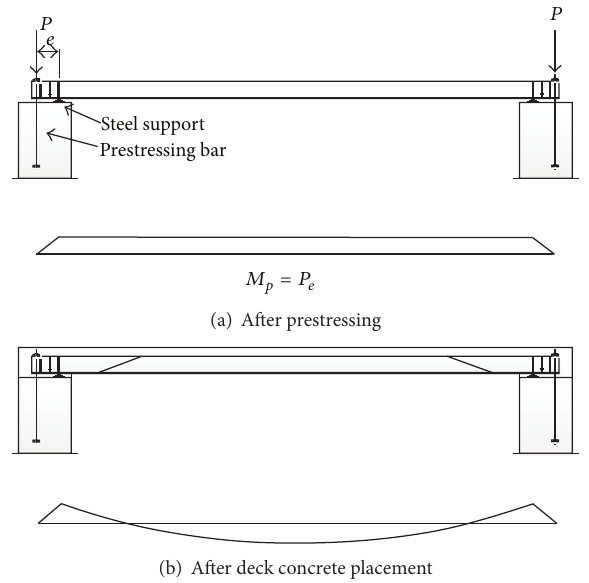
Figure 1: Principle of vertically prestressed composite